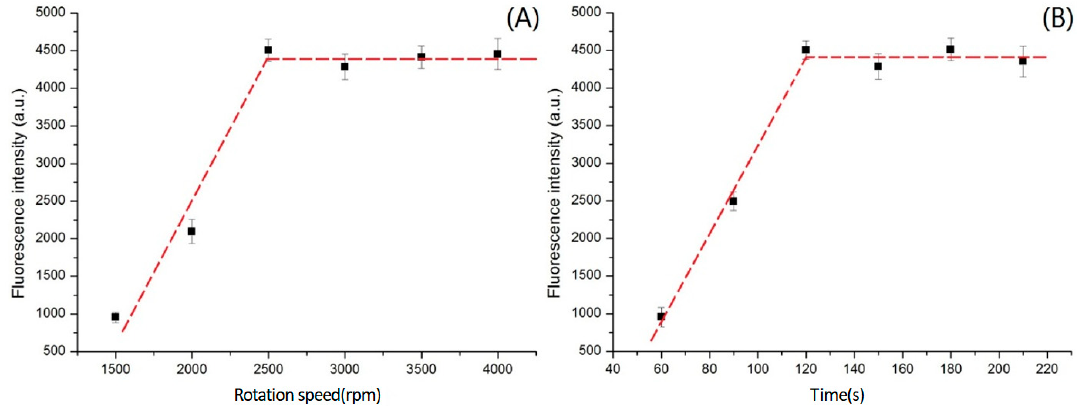
Figure 3. Effects of rotation speed and spin duration on carcinoembryonic antigen (CEA) isolation. ( A ) the effect of rotation speed on CEA isolation; ( B ) the effect of spin duration on CEA isolation.